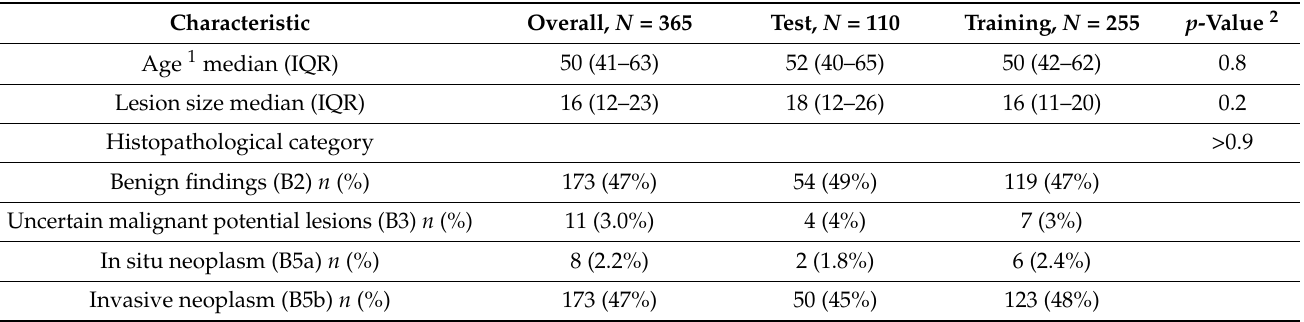
Table 1. Histopathological characteristics in the training and test